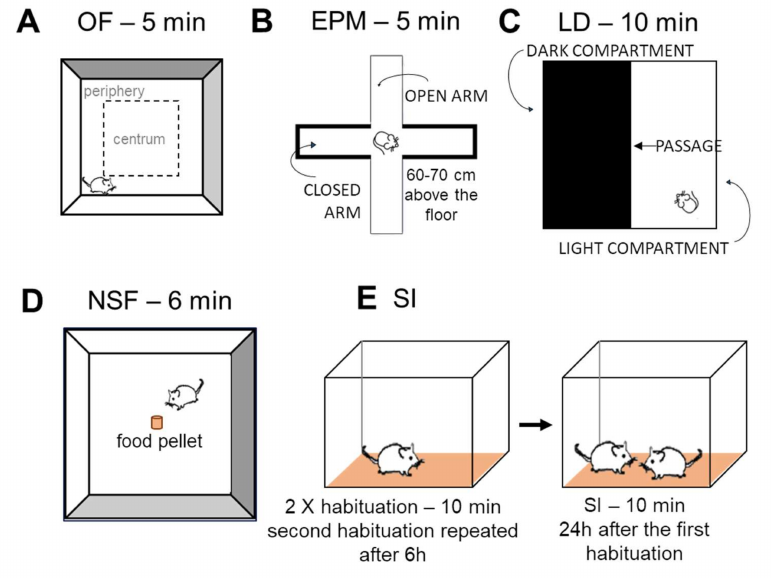
Figure 7. Schematic representation of behavioral tests measuring anxiety-like behavior. ( A ): Open field (OF) test (the first phase of SD). Animals had 5 min to explore the new environment. ( B ): Elevated plus maze test (EPM). Mice were put into the center of EPM, which had open and closed, highly walled parts. The test lasted 5 min. ( C ): Light-dark (LD) box. Mice were put into the light part of the box. There was also a dark compartment with black walls and cover. The two compartments were passable through a small gate. LD test lasted 10 min. ( D ): Novelty suppressed feeding (NSF). Sniffing and eating food in a novel environment after a 24 h period of food deprivation was measured for 6 min. ( E ): Social interaction (SI) test. After habituation to the test cage, mice were placed into a plexiglass aquarium with bedding at the same time and were then tested for 10 min for the following parameters: friendly, aggressive, or defensive social behavior, and other non-social